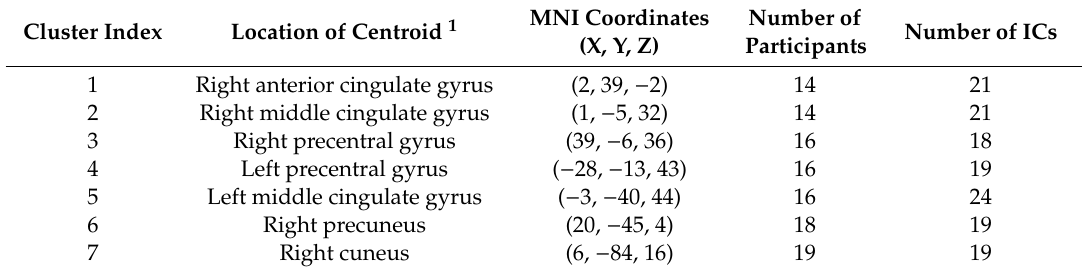
Table 1. Montreal Neurological Institute (MNI) coordinates and labels of the centroids of independent component (IC) clusters.